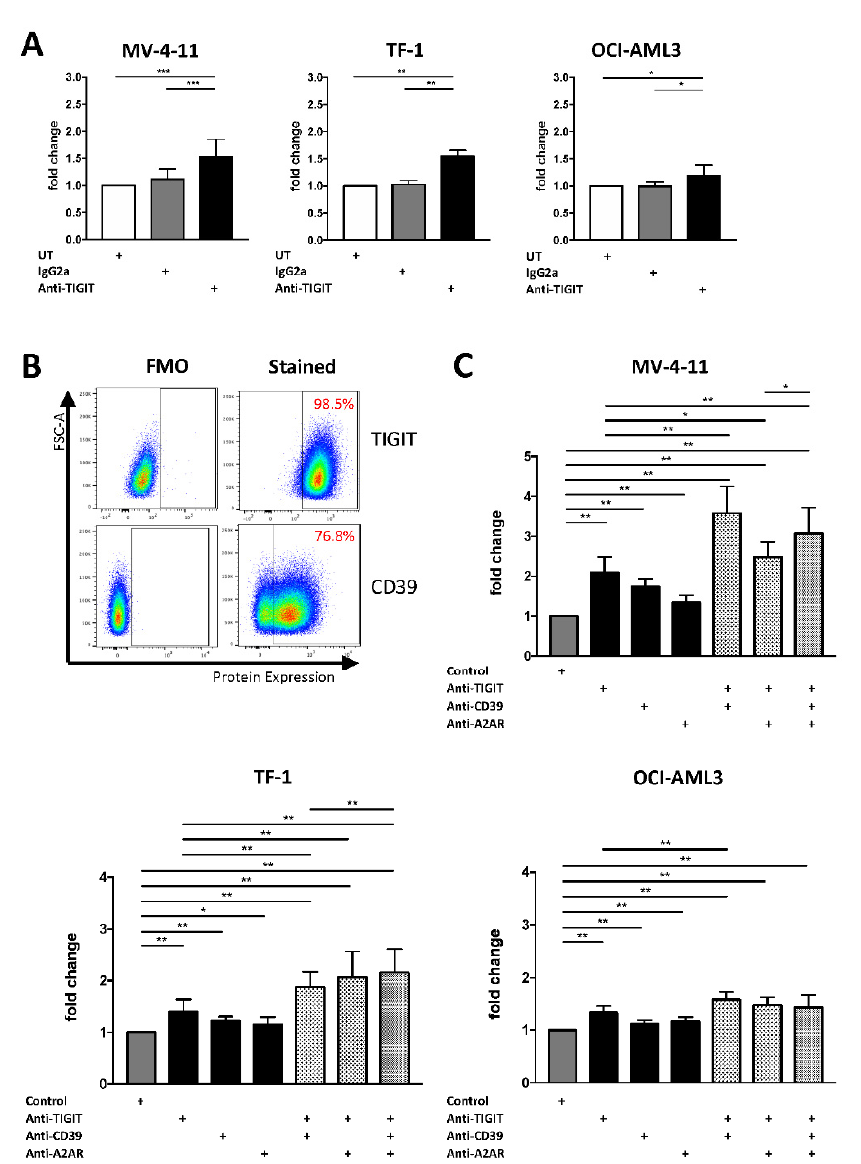
Figure 5. NK-92 cell-mediated cytotoxicity can be augmented by a combined blockade of TIGIT together with CD39 or A2AR. Blockade of TIGIT, CD39, and A2AR was analyzed for NK-92 cells co-cultured with AML cells over 24h in vitro. ( A ) Effects of the TIGIT blockade on NK cell-mediated lysis were analyzed by detecting the frequency of lysed AML cells that was defined by double positivity of CT green and 7-AAD measured by MFC analysis. Summary data are depicted as the mean ± SD fold changes, relative to the untreated condition for the AML cell lines MV-4-11 ( n = 5), TF-1 ( n = 4), OCI-AML3 ( n = 4). ( B ) Representative flow cytometry plots showing the expression of TIGIT and CD39 on NK-92 cells. ( C ) NK cell-mediated lysis with the single blockade of TIGIT was compared with the additional administration of CD39 and A2AR blocking. Results are depicted as the mean ± SD fold changes of dead target cells, relative to the control containing the isotype controls and DMSO. Again, NK cell cytotoxicity was tested for the AML cell lines MV-4-11 ( n = 3), TF-1 ( n = 3), OCI-AML3 ( n = 3). All measurements were performed in technical triplicates. p values were obtained by the Wilcoxon test. * p < 0.05, ** p < 0.01, *** p < 0.001. Due to these promising results, we tested the effects of the TIGIT blockade in com- bination with an inhibition of the purinergic pathway on NK cell-mediated killing.